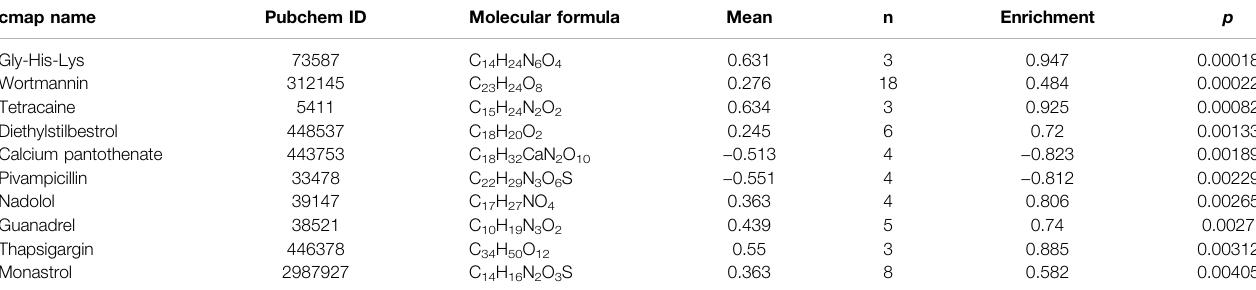
TABLE 1 | Top ten chemicals were predicted as putative therapeutic agents for smoking-related